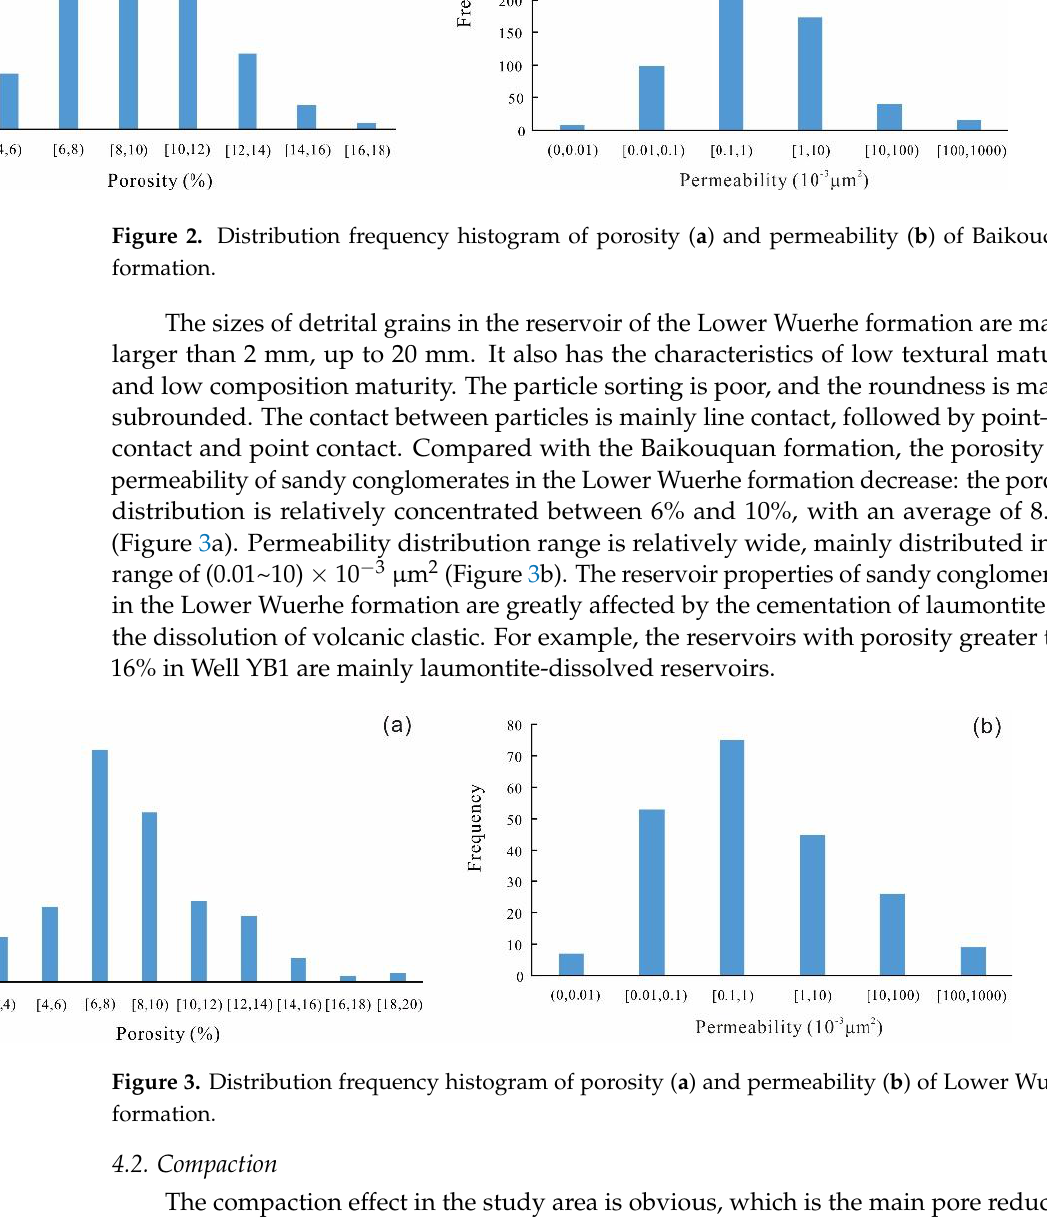
Figure 4. Cast thin sections of compaction in study area. ( a ) well YT1, 4821.9 m, Lower Wuerhe formation, sandy conglomerates, grains in close contact, line contact – concavo – convex contact; ( b ) well YT1, 4810 m, Lower Wuerhe formation, medium sandstone, grains in close contact, line con- tact – concavo – convex contact; ( c ) well MZ4, 3580 m, grains in close contact, sutured contact; ( d ) well M18, 3438.3 m, grains in close contact, sutured contact.